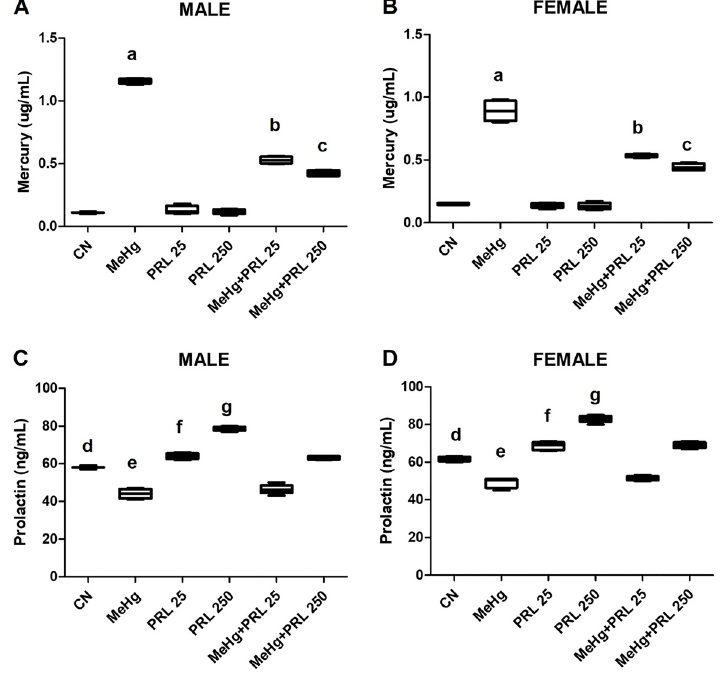
Figure 7. Serum mercury level ( A and B ) and serum prolactin level ( C and D ) of each treatment group. Data are reported as medians and interquartile range. a,b,c P o 0.01 compared to all other treatments (mercury); d,e,f,g P o 0.01 compared to all other treatments (prolactin) (ANOVA with Tukey ’ s post-test). CN: control group; MeHg: methylmercury; PRL 25 and PRL 250: 25 and 250 m g/kg prolactin, respectively, every 12 h.